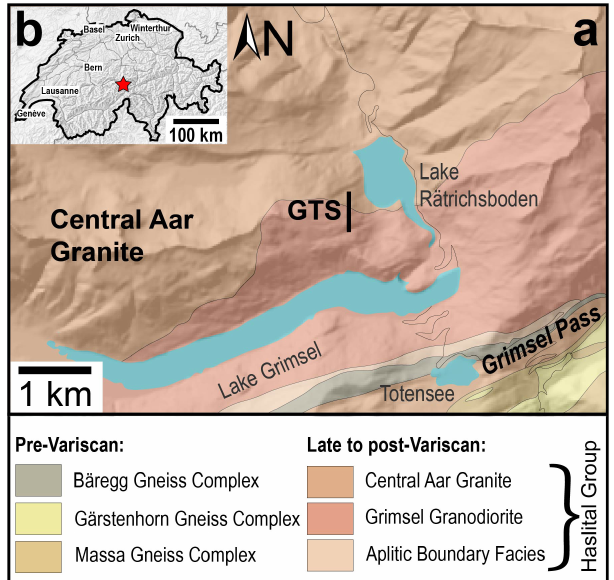
Figure 1. (a) Geological map of the Grimsel Pass area (redrawn from Wehrens et al., 2016). (b) Geographic location of the Grim- sel Pass area (red star) in Switzerland (modified from https://www. map.geo.admin.ch; last access: 11 November 2022). The digital el- evation model in panel (a) is from https://www.map.geo.admin.ch; last access: 11 November 2022.